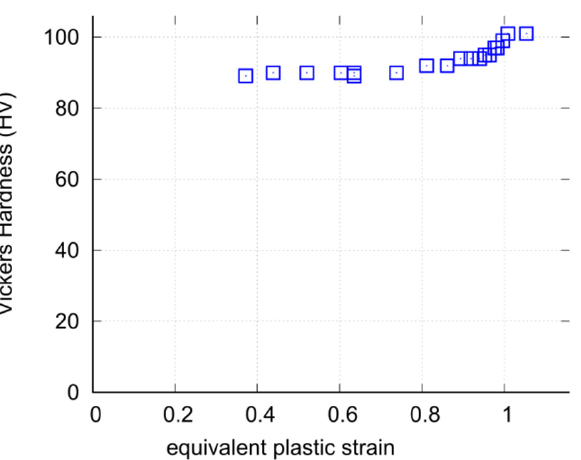
Figure 14. Microhardness as a function of the equivalent plastic strain at the 21 points indicated in Figure 5.